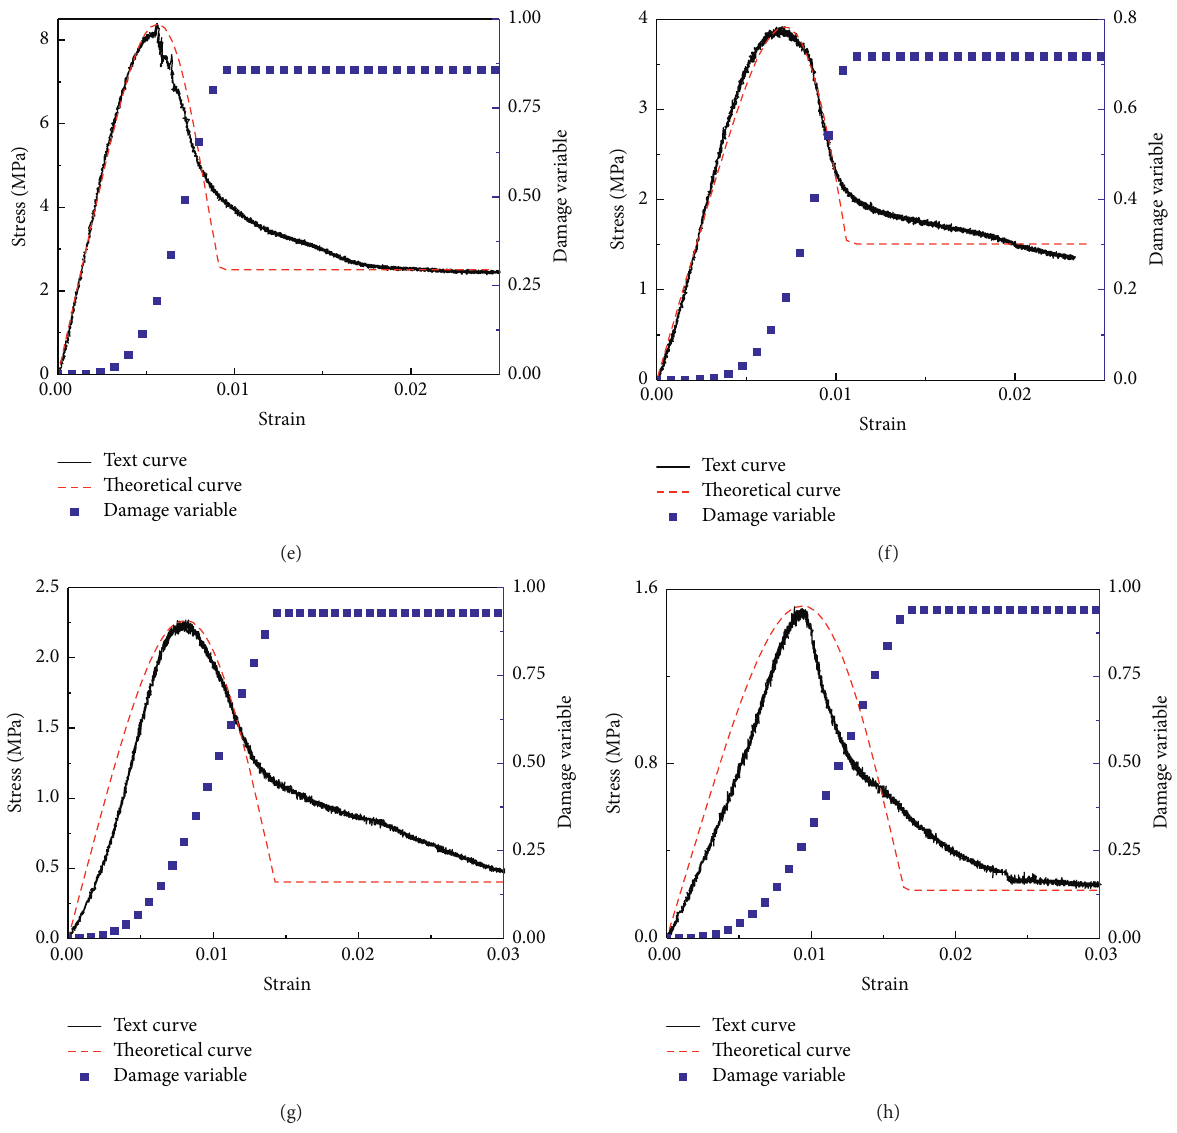
Figure 6: Damage variable and comparison of damage constitutive models. (a) Cement-tailings ratio is 1 :4 and slurry concentration is 70%; (b) cement-tailings ratio is 1:4 and slurry concentration is 72%; (c) cement-tailings ratio is 1:4 and slurry concentration is 74%; (d) cement- tailings ratio is 1 :4 and slurry concentration is 76%; (e) cement-tailings ratio is 1: 4 and slurry concentration is 78%; (f) cement-tailings ratio is 1: 6 and slurry concentration is 76%; (g) cement-tailings ratio is 1 :8 and slurry concentration is 76%; (h) cement-tailings ratio is 1:10 and slurry concentration is